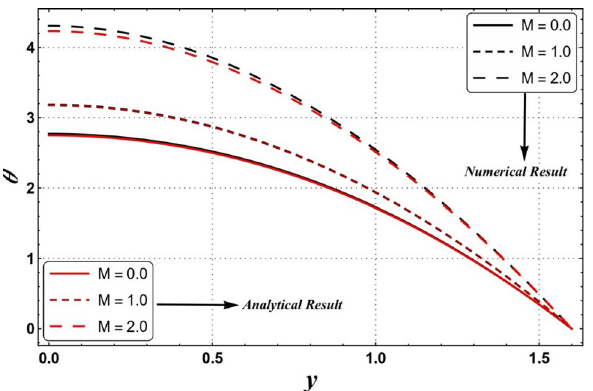
Figure 9. A comparison of the results obtained at analytical technique (HPM) and numerical technique